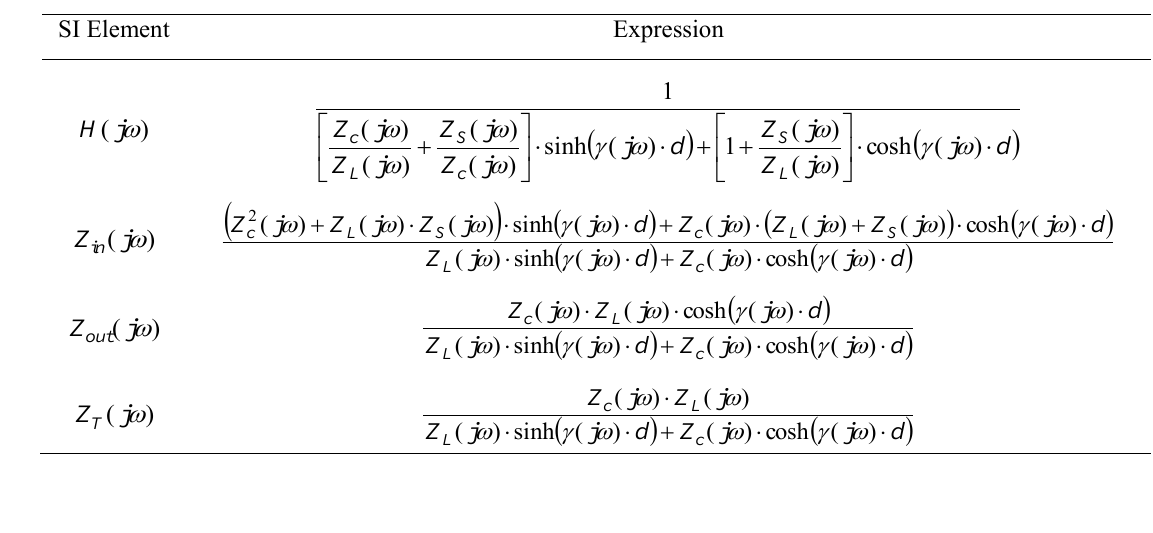
Table 1: Summary of extracted frequency-domain SI parameters.